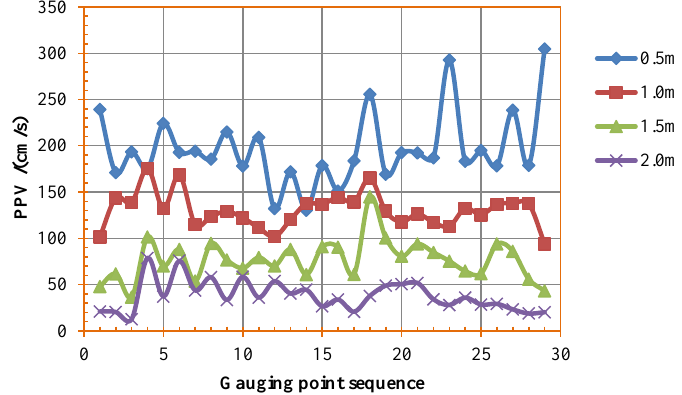
Figure 17. Presentation of peak particle velocities (PPVs) obtained from numerical study on a log-log scale.